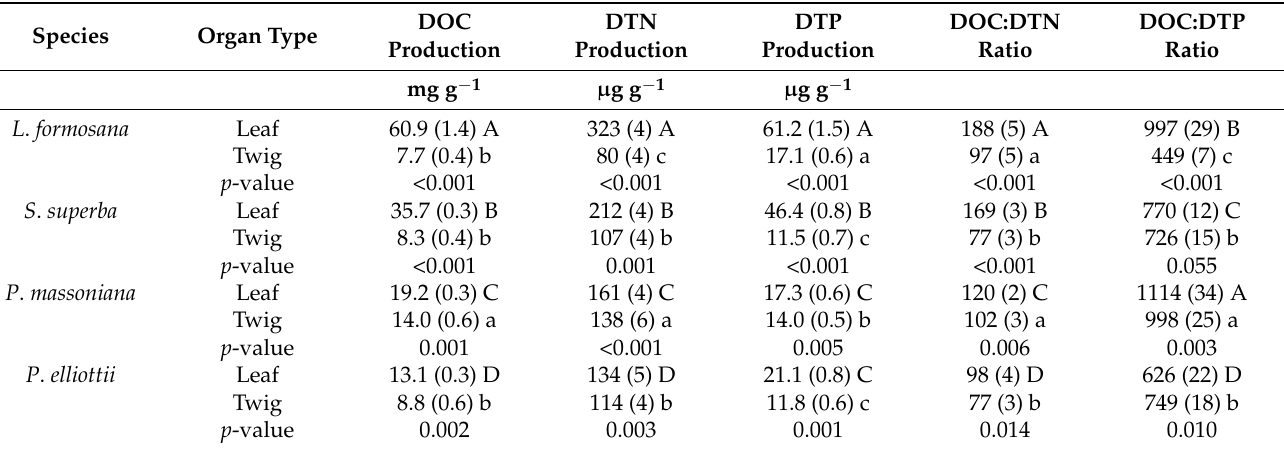
Table 3. Dissolved organic C (DOC), dissolved total N (DTN), and dissolved total P (DTP) produc- tions, and stoichiometric ratios of tree tissue leachates in subtropical plantations in southern